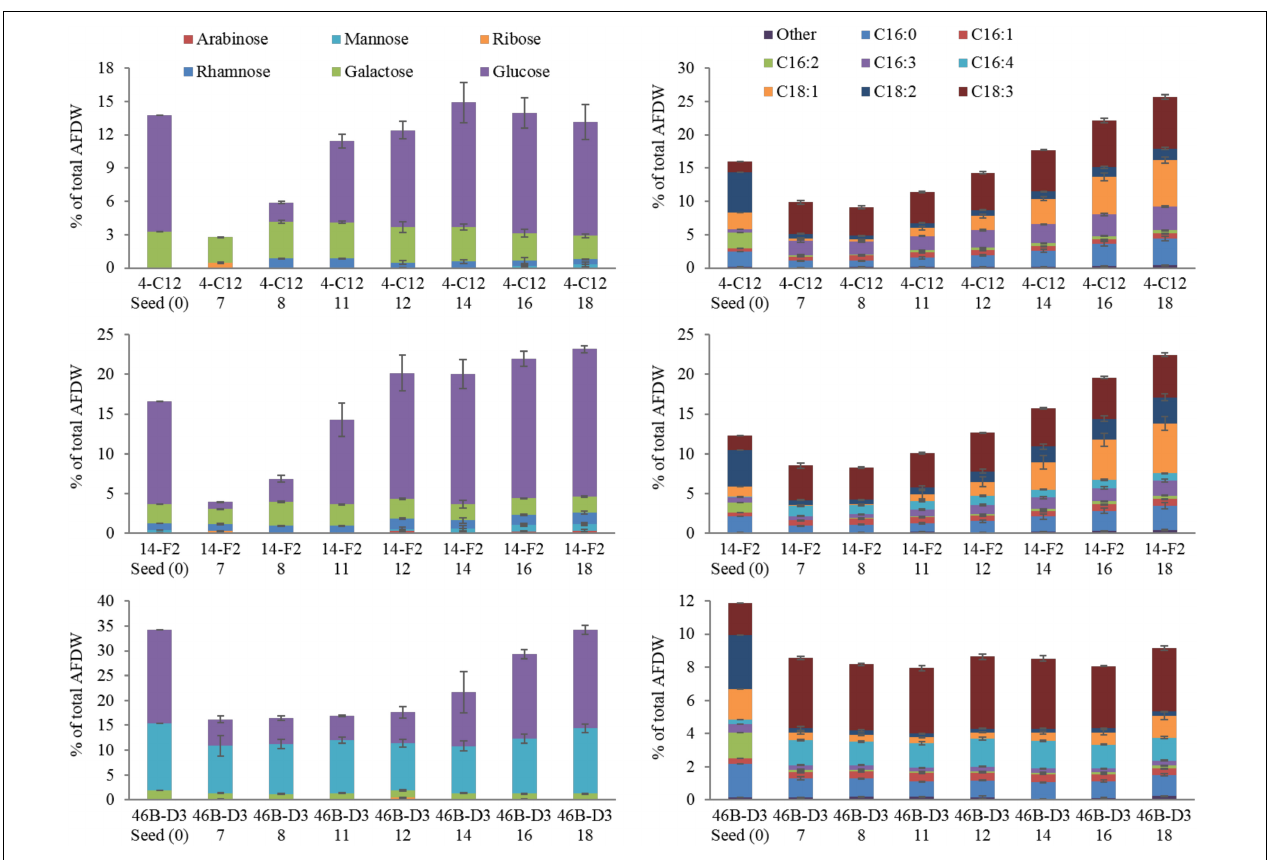
FIGURE 4 | Carbohydrate and FAME profile of strains grown outdoors during the winter month of February 2016 (1st–19th), x axis lists the strain and time in days. Average and standard deviation error bars are from 3 biological replicates.